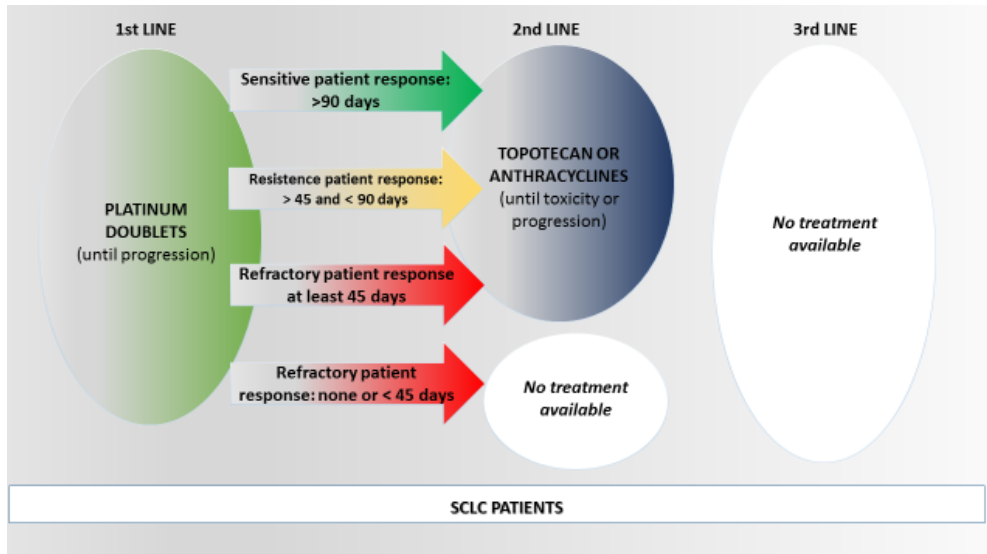
FIGURE 1 - standard treatment for